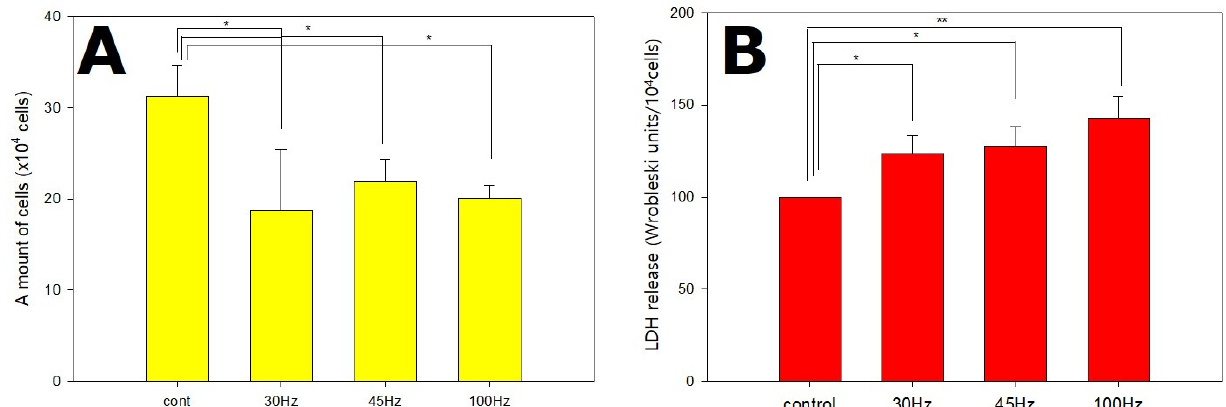
Figure 1. The proliferation ( A ) and lactate dehydrogenase (LDH) secretion ( B ) of human dental pulp stem cells (HDPSCs) subjected to 14 d of mechanical vibrations. HDPSCs were seeded at a density of 2 × 10 4 cells/well in 6-well plates, and their proliferation was measured after 14 d by counting the viable cells. The growth of the cells was significantly inhibited by mechanical vibration ( n = 3), and the 100 Hz mechanical vibration group showed higher levels of LDH production than the control ( n = 6). * p < 0.05, ** p < 0.01, *** p < 0.005 (compared with the control).